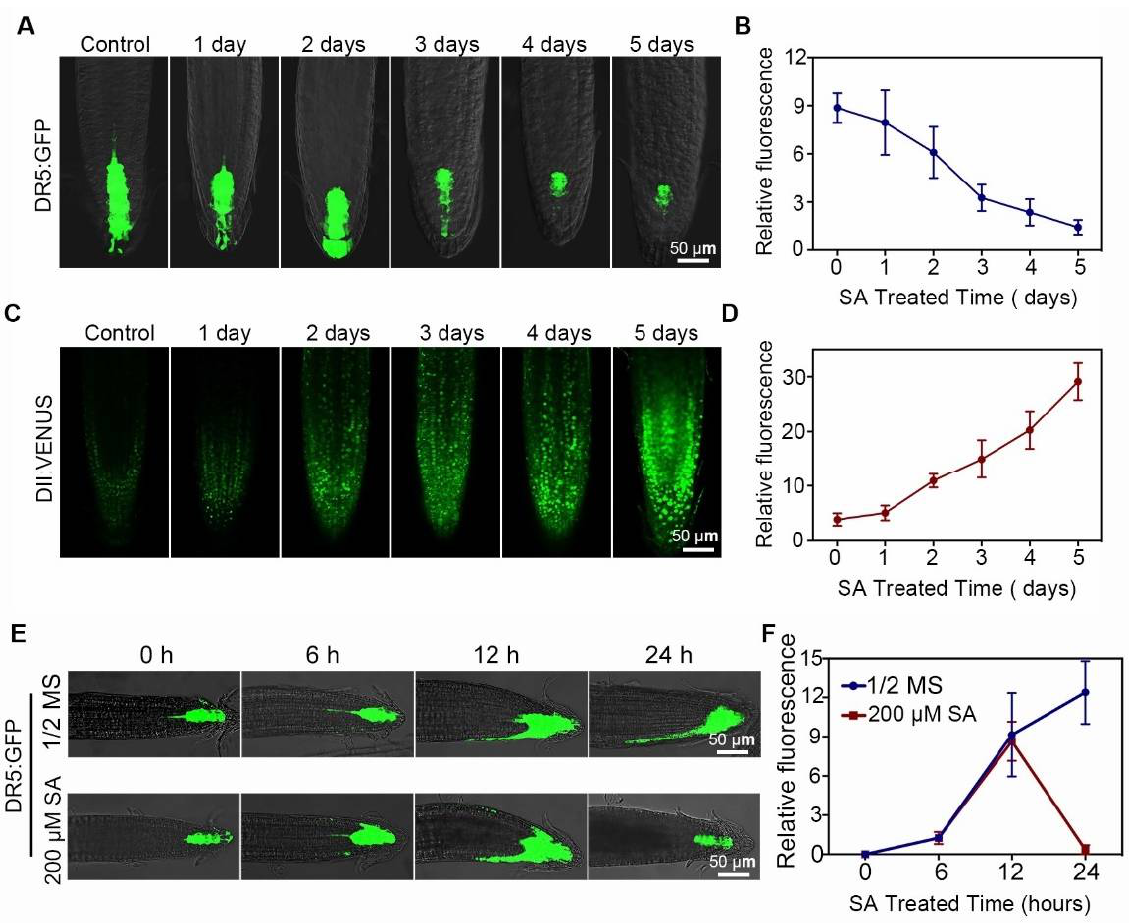
Figure 2. Effects of high-concentration SA on auxin accumulation and transportation. ( A , B ) Auxin accumulation in transgenic DR5-GFP seedlings. Three-day-old DR5-GFP seedlings grown on 1 / 2 MS were treated with 200 µ M SA for 1, 2, 3, 4 and 5 days, respectively. DR5-GFP signal (fluorescence intensity) was examined after the respective treatment (n = 4). ( C , D ) Auxin degradation in transgenic DII-VENUS seedlings. Three-day-old DII-VENUS seedlings grown on 1 / 2 MS were treated with 200 µ M SA for 1, 2, 3, 4 and 5 days, respectively. DII-VENUS signal (fluorescence intensity) was examined after the respective treatment (n = 4). ( E , F ) Auxin distribution in transgenic DR5-GFP seedlings. Five-day-old DR5-GFP transgenic seedlings were transferred to 1 / 2 MS medium containing 0 or 200 µ M SA and cultured for 0 h, 6 h, 12 h and 24 h after 90 ◦ re-orientation. DR5-GFP signal (fluorescence intensity) was examined after the respective treatment (n = 4). Error bar = standard deviation (SD).